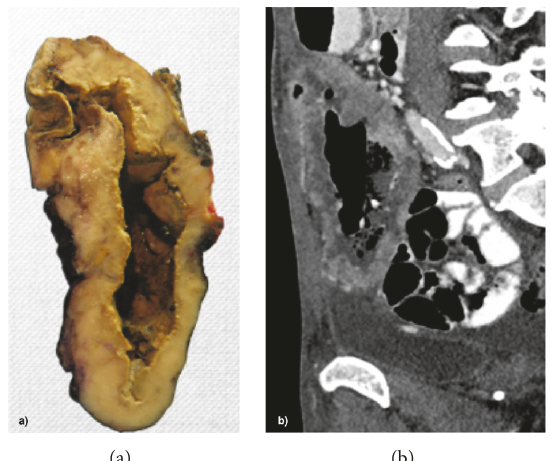
Figure 5: Radiologic-pathologic correlation of the tumor ((a) sagittal CT image; (b) cross section of the gross specimen), showing a large and heterogeneous mass, with thickened wall and central necrotic